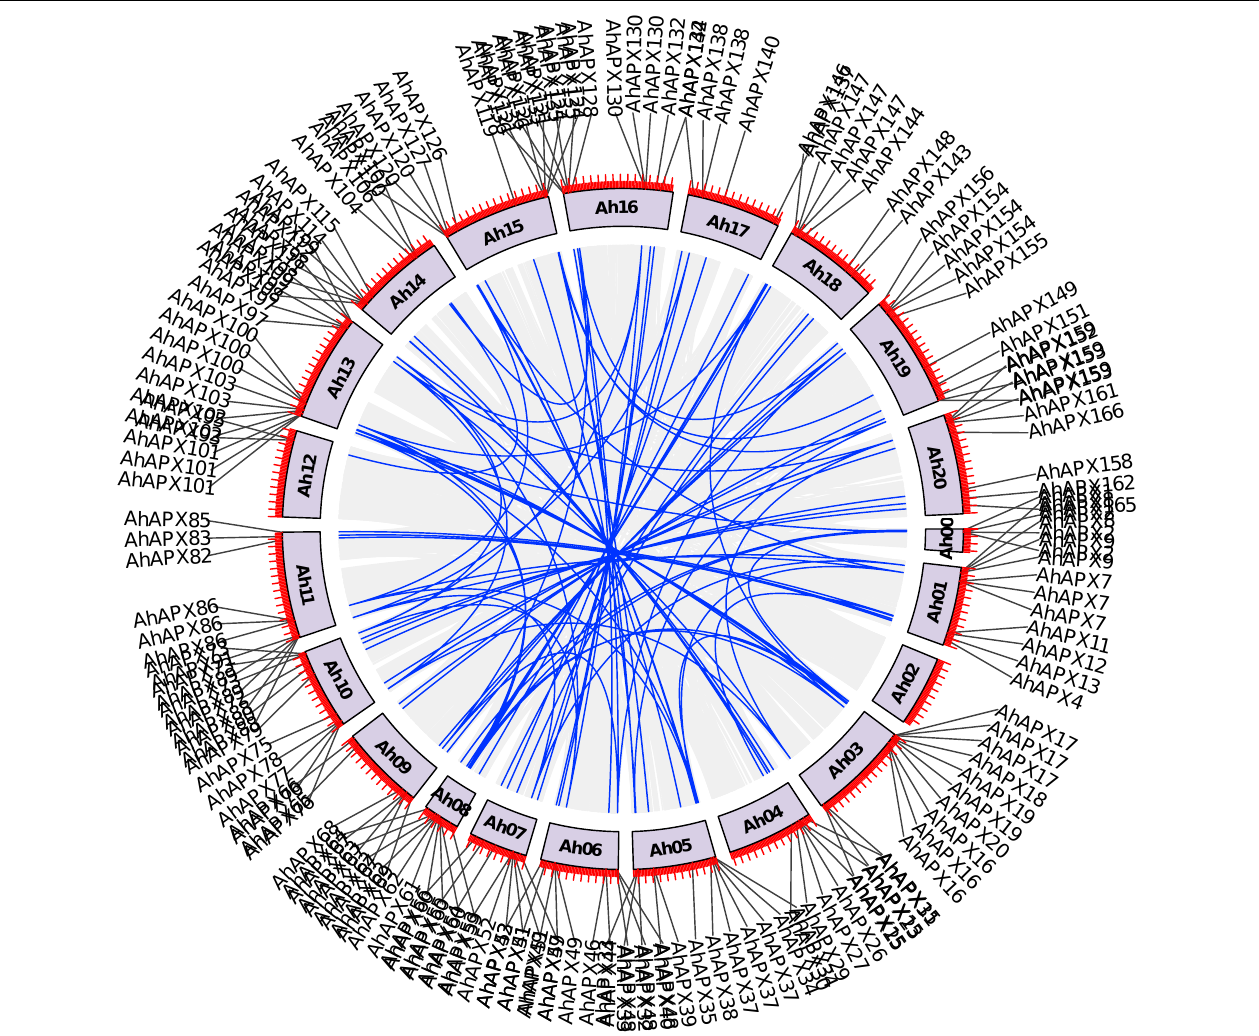
FIGURE 3 | Chromosomal positions and inter-chromosomal groups of duplicated AhAPX gene pairs. Gray lines in the background demonstrate all syntenic blocks in the A. hypogea genome, and the blue lines exhibit the segmental or tandem duplication network zones among AhAPX genes. The near location of AhAPX genes is marked with black lines outside with chromosome